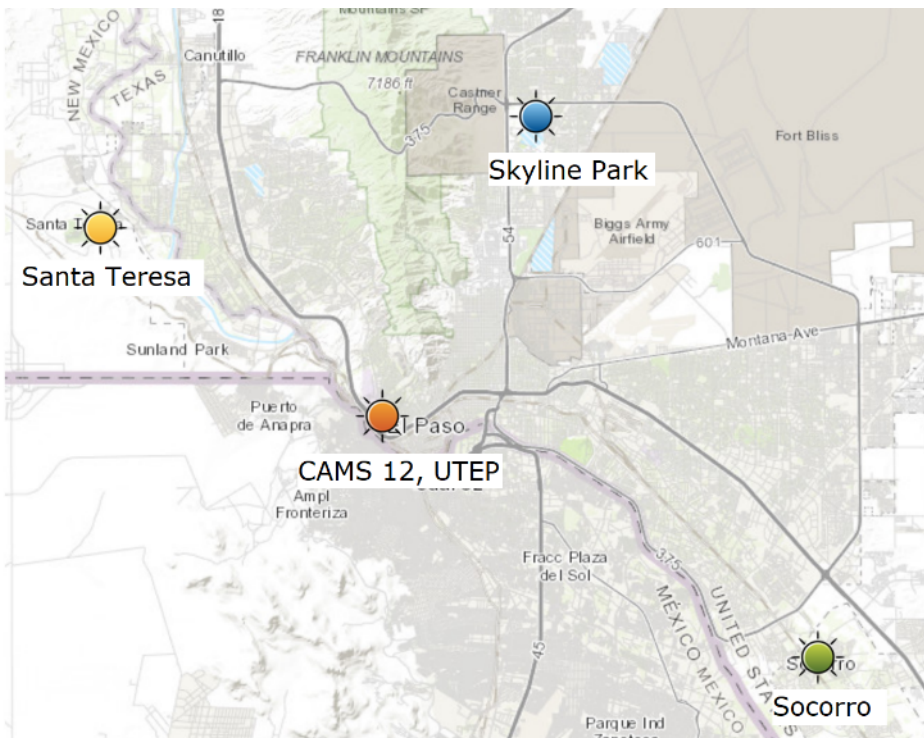
Figure 3. Data location sites in the Paso del Norte area.